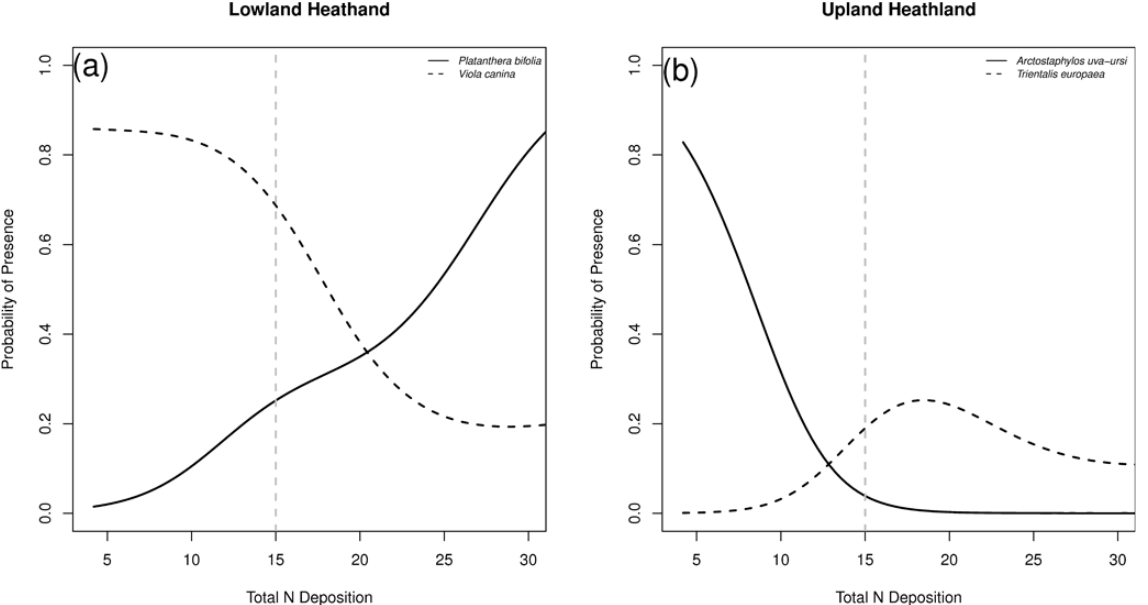
Fig. 5. Change in probability of presence for species showing statistically significant relationships to N deposition in heathland in the Vascular Plant database against increasing total inorganic N deposition (kgNha − 1 yr − 1 ) . The dashed grey line indicates the midpoint of the critical load range for heathlands as defined by Bobbink and Hettelingh (2011).